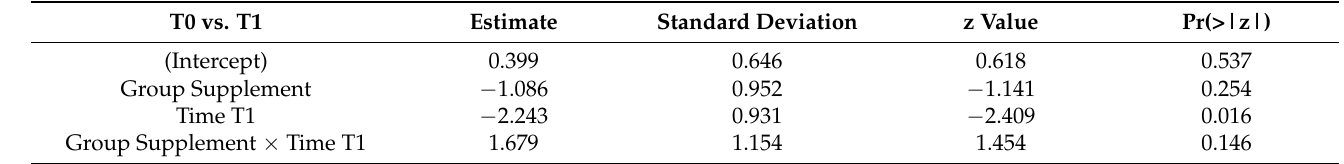
Table 5. Best “Effect” Estimate of Patellar Tracking. Fixed effects from multilevel model of patellar tracking at times T0 vs.